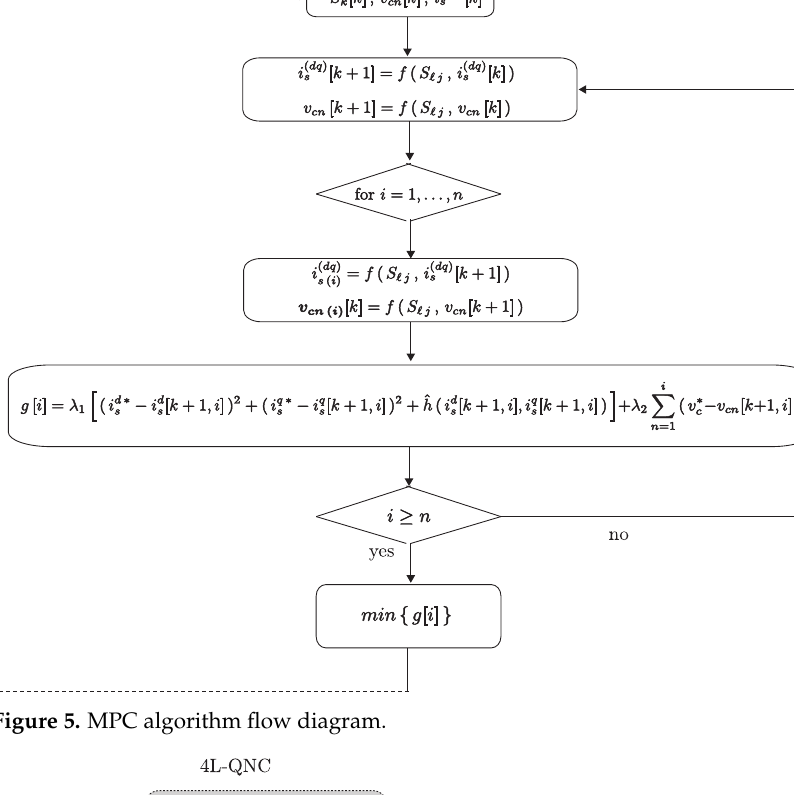
Figure 5. MPC algorithm flow diagram.